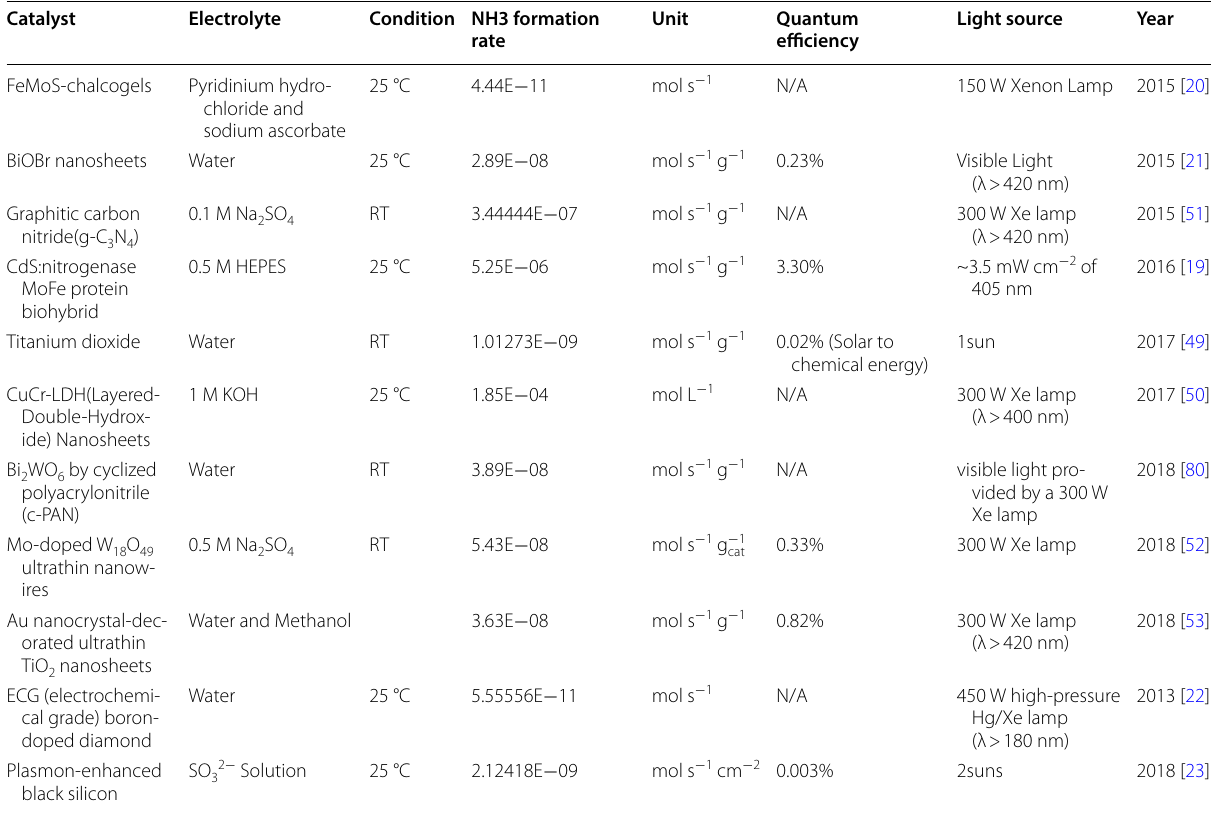
Table 2 A brief summary of the representative experimental studies on NRR using various photocatalytic